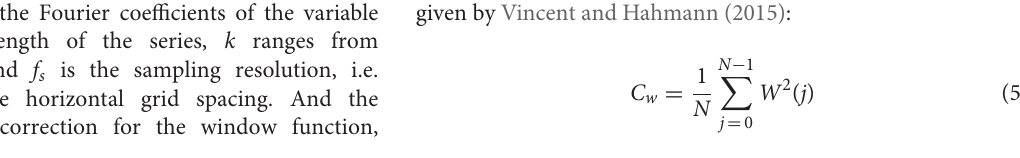
Where A ( k ) represents the Fourier coefficients of the variable in study, N is the length of the series, k ranges from 0 6 k 6 N / 2, and f s is the sampling resolution,